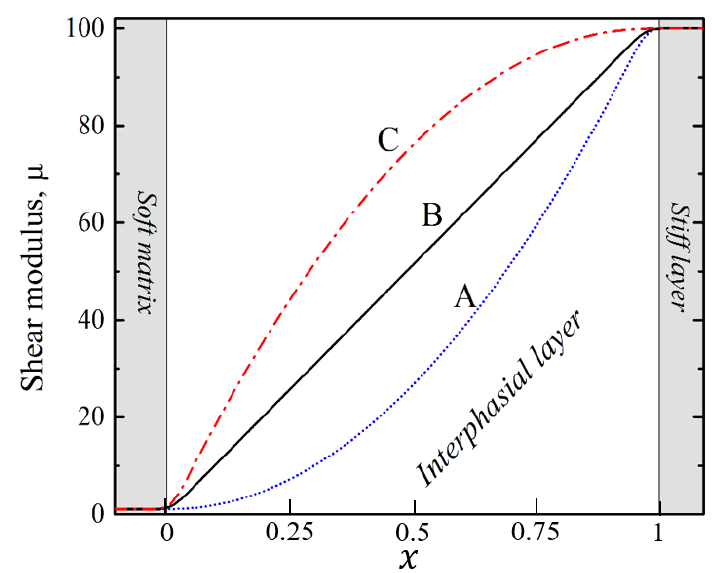
Figure 2. Different types of shear modulus variation in the interphasial layer.